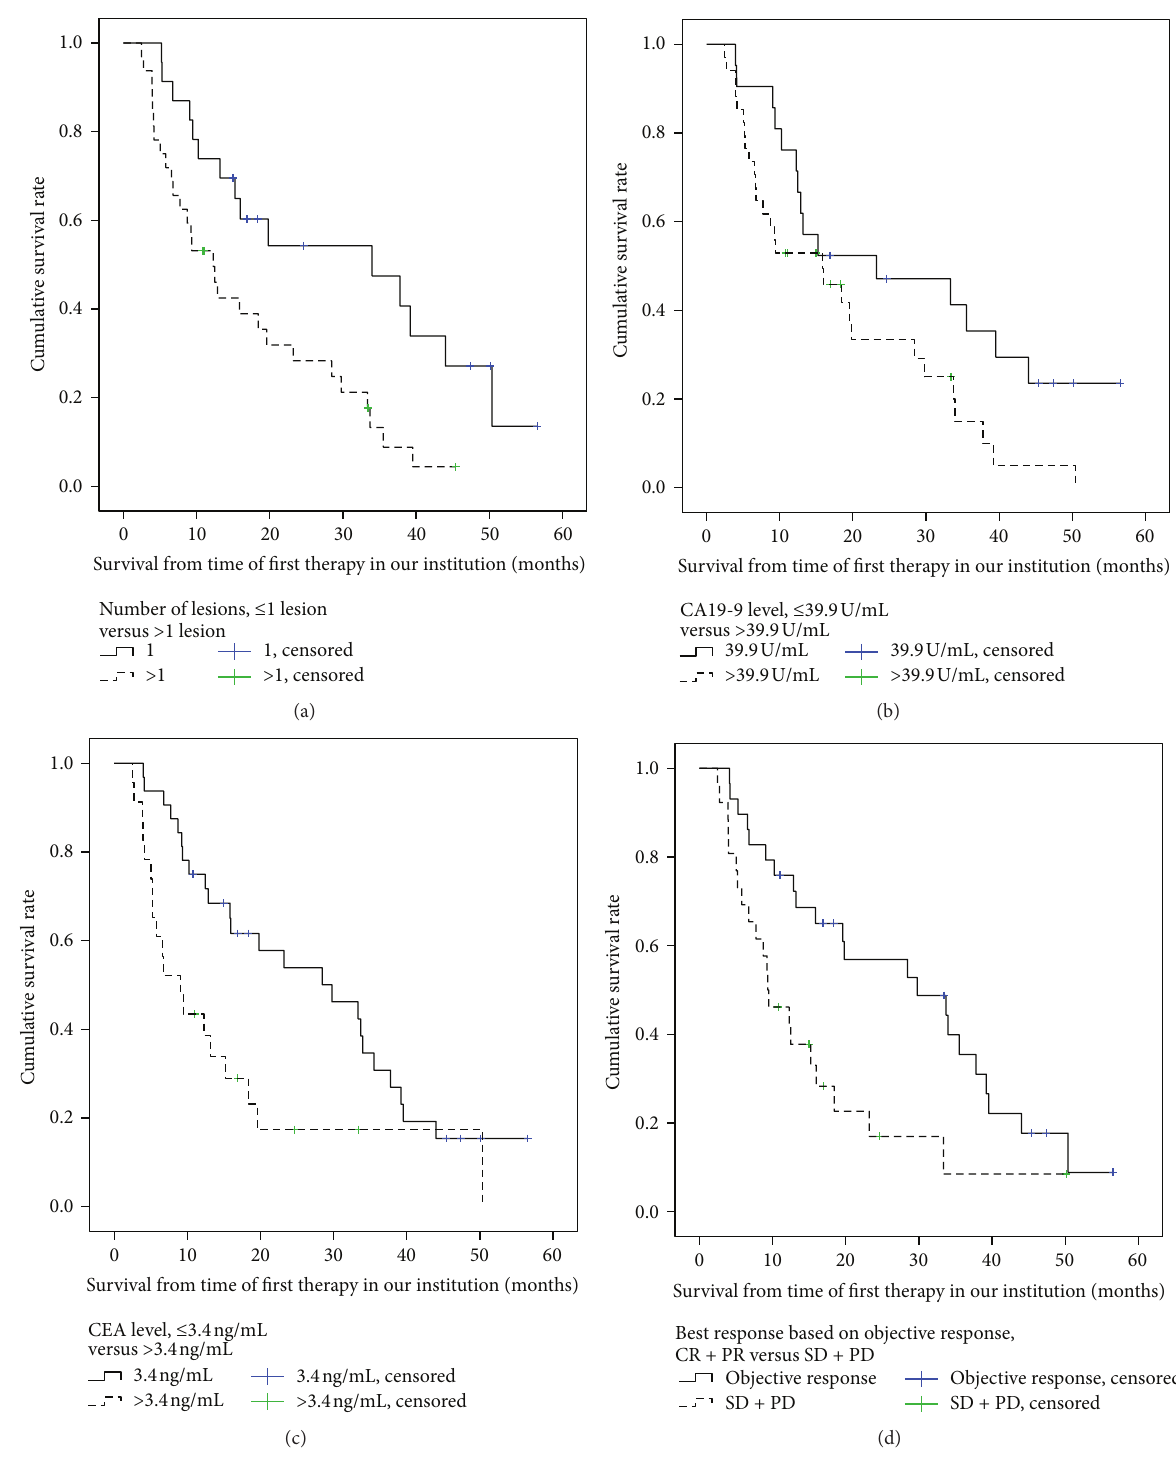
Figure 3: Overall survival rate in all patients according to influencing factors (derived from Cox model, Table 3). (a) Overall survival rates with regard to number of lesions ( ≤ 1 lesion versus > 1 lesion), with a median overall survival of 34 and 12.3 months, 𝑝 = 0.006 . (b) Overall survival rates with regard to CA 19-9 level ( ≤ 39.9 U/mL versus > 39.9 U/mL) with a median overall survival of 23.2 and 15.9 months, 𝑝 = 0.043